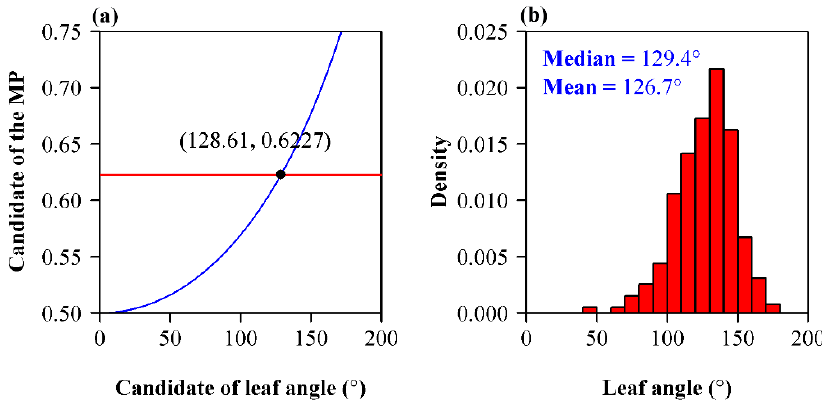
Figure 8. Estimation of the leaf angle of G. biloba . ( a ) Numerical solution of the leaf angle of the population of G. biloba ; ( b ) histogram of the numerical solutions for different individual leaves sampled. In panel ( a ), the red horizontal straight line represents the estimate of the Montgomery parameter; the blue curve represents δ / [ 4 sin ( δ /2 )] (see Equation (3)), where δ represents the candidate of leaf angle that was initially set from π /4000 to π by an increment of π /4000; the point at which the red straight line and the blue curve intersect is used to quantify the leaf angle of the population (namely all the leaves sampled). In panel ( b ), red bars represent the densities of different groups of leaf angles.